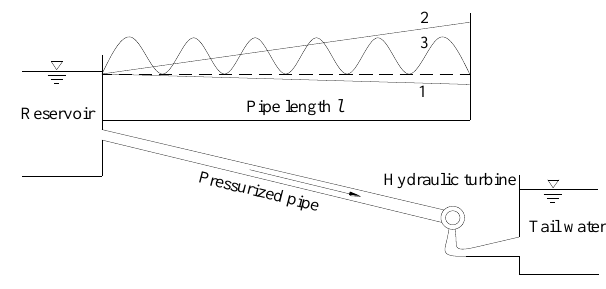
Figure 1. Conceptual distributions of different water pressures.